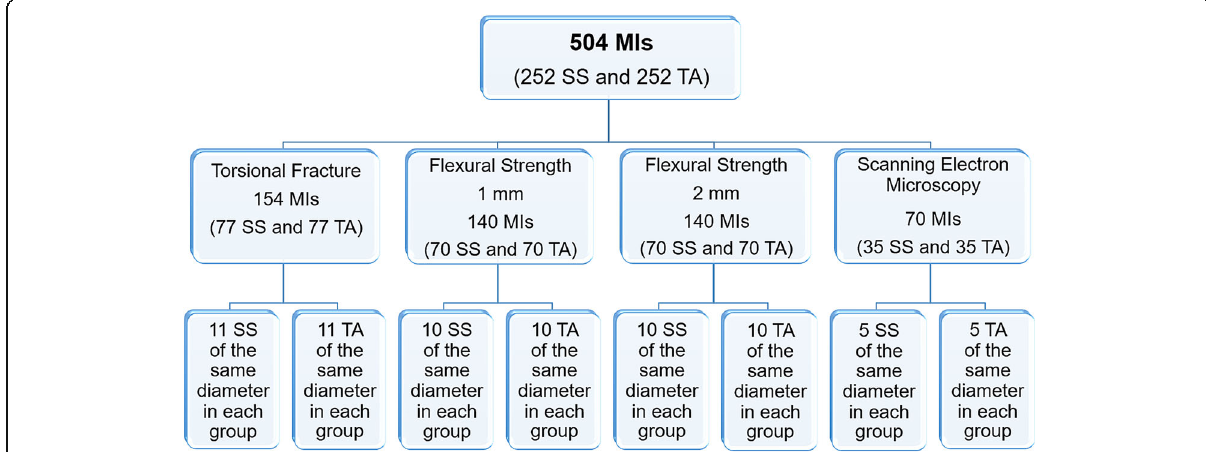
Fig. 2 Flowchart of MI sample distribution. Five hundred and four self-drilling, tapered, 8-mm-long MIs with diameters ranging in increments of